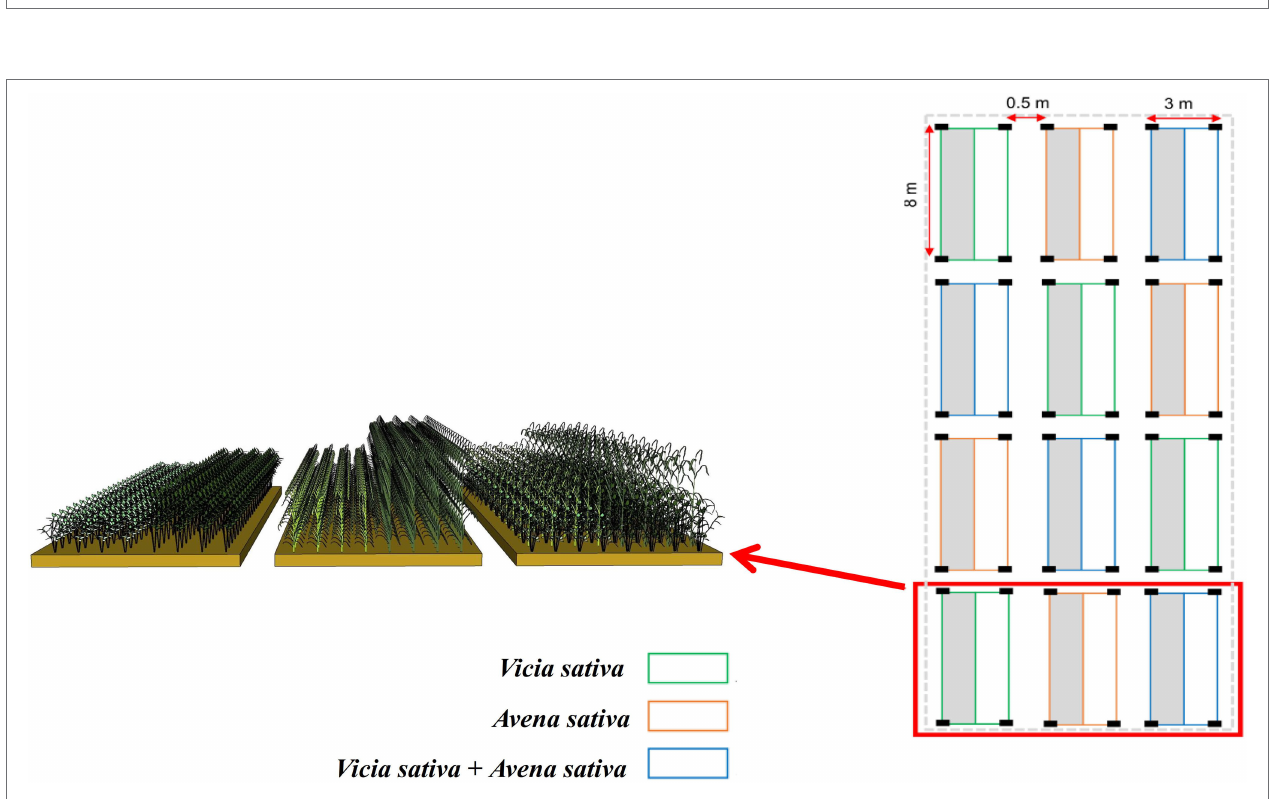
FIGURE 2 | Mean month air temperature (mm, bars) and precipitation rates ( ° C, lines) measured at Yuzhong county research station (Lanzhou city, Gansu province, China) from 2013 to 2016. This figure uses the ratio of 10 ° C vs. 20 mm as in the standard Walter-Lieth climate diagrams.